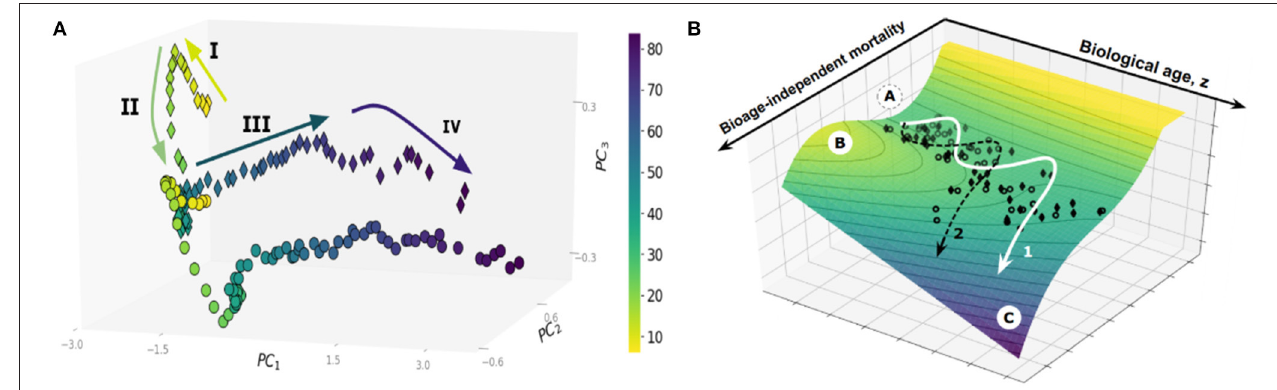
FIGURE 1 | (A) Principal Component Analysis of human physical activity time series representations from an NHANES study. (B) The trajectory of aging is shown superimposed on the potential energy landscape (vertical axis), which provides a schematic visualization of the constraints provided by the underlying regulatory network. Each dot represents the physical activity state vectors of an age-and sex-matched cohort of NHANES participants (men, diamonds; women, circles). Cohorts were categorized by one year increments. The axes in the horizontal plane are (i) biological age (in years), and (ii) biological age-independent mortality. The stability basin A is separated from the unstable region C by the potential energy barrier B; The figures are adopted from Pyrkov et al.